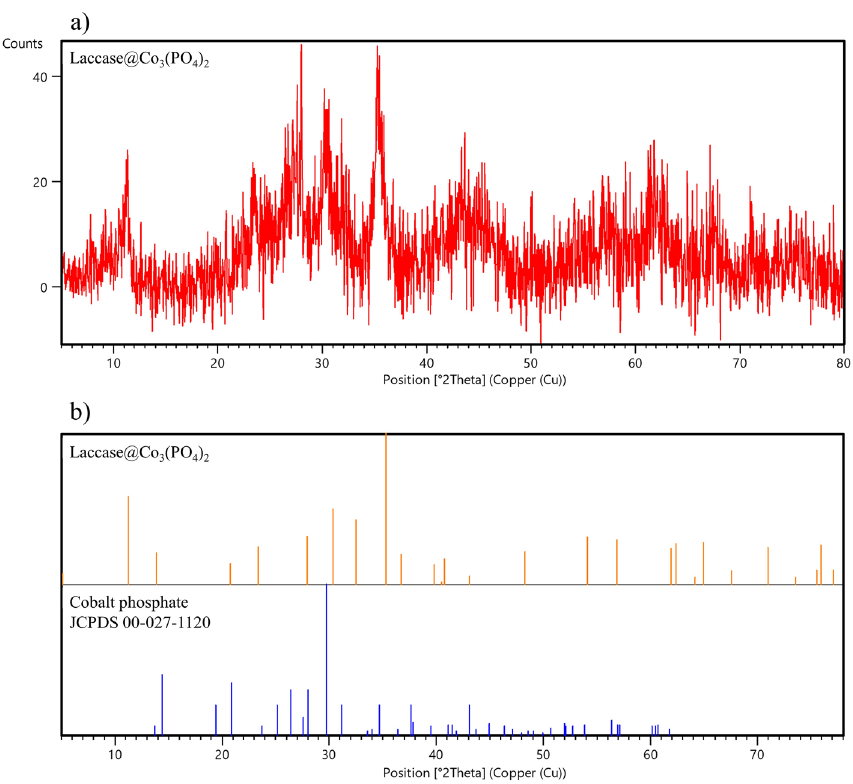
Figure 3. X-ray diffraction (XRD) analysis. X-ray spectrum of laccase@Co 3 (PO 4 ) 2 •HNFs ( a ), XRD pattern of